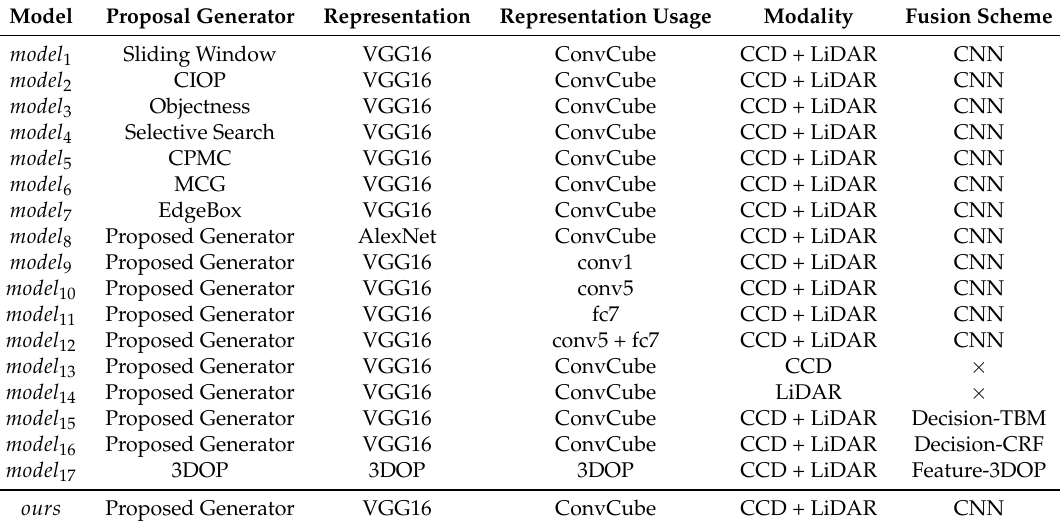
Table 2. Comparison models used to evaluate the proposed method. ConvCube, convolutional cube; CIOP, category independent object proposals; CPMC, constrained parametric min-cuts; MCG, multiscale combinatorial grouping; TBM, transferable belief model; CRF, conditional random field; 3DOP, 3D object proposal.